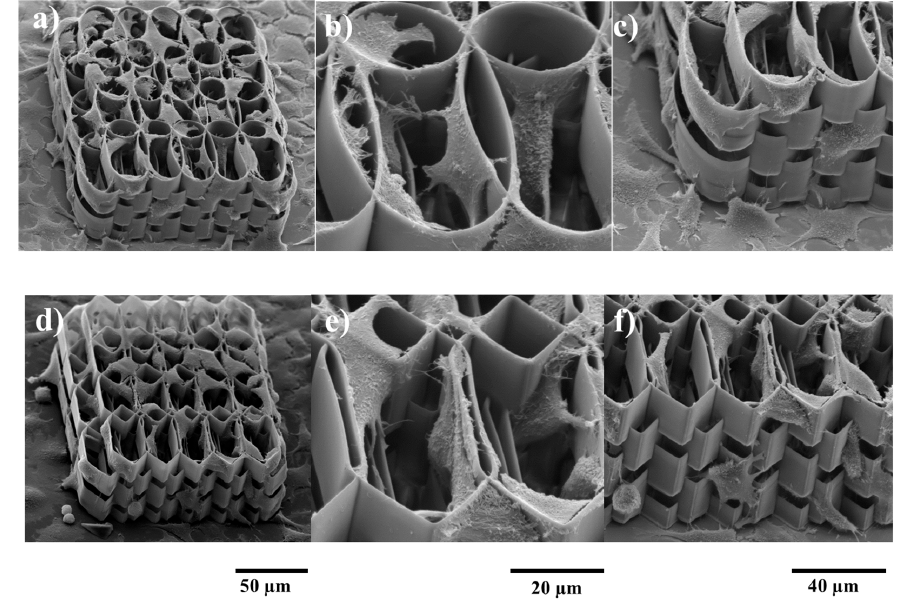
Figure 2. SEM (scanning electron microscopy) micrographs of MG-63 osteoblast like cells seeded for two days on ellipsoidal (upper panel) and hexagonal (lower panel) multilayered 3D structures. ( a , d ) Overviews of cells attachment on the structures; ( b , e ) Cells penetrating inside the structures; ( c , f ) Cells growing on the lateral walls of the structures.